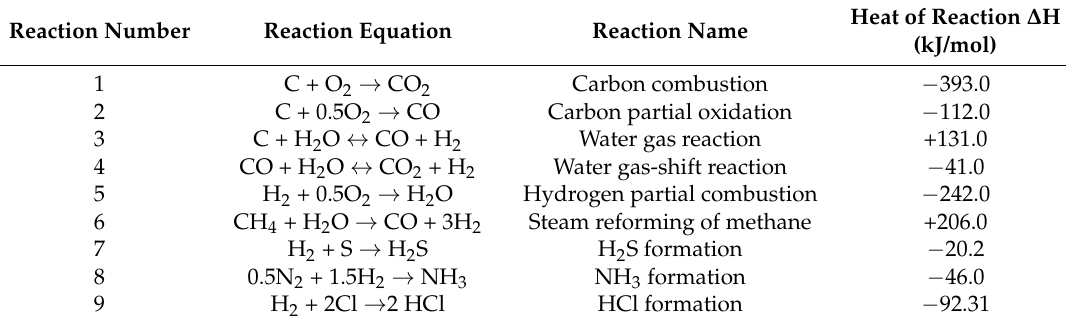
Table 4. Chemical reactions involved in the